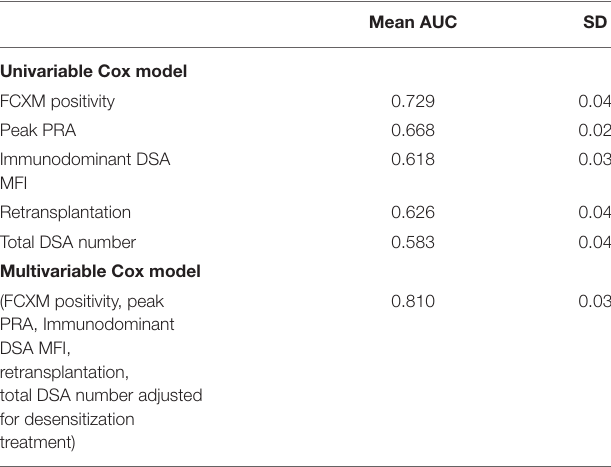
TABLE 5 | Area under curve for uni- and multi-variable Cox regression for ABMR risk in 10-fold